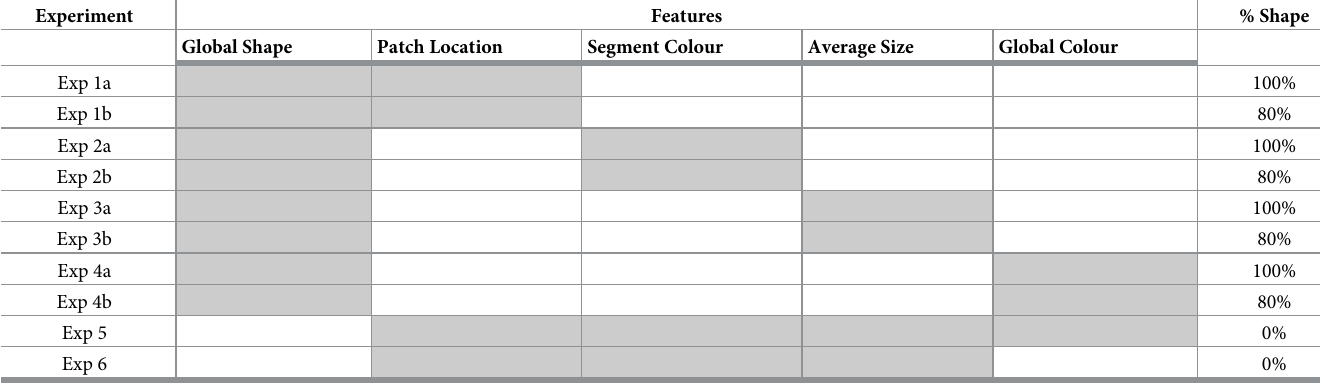
Table 1. Feature combinations examined in different experiments.